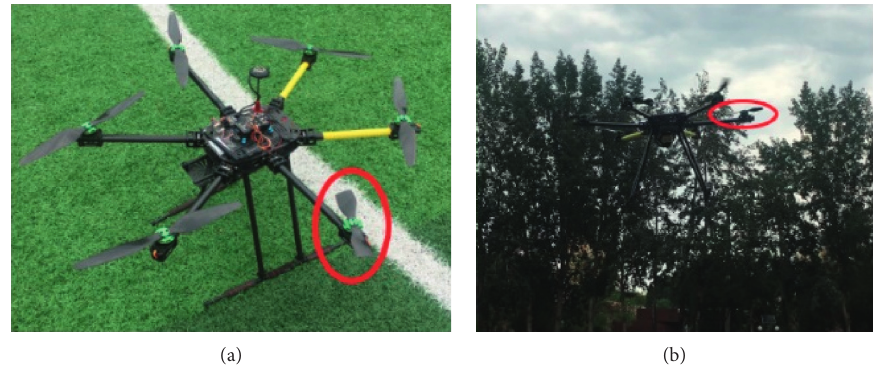
Figure 14: Actual flight